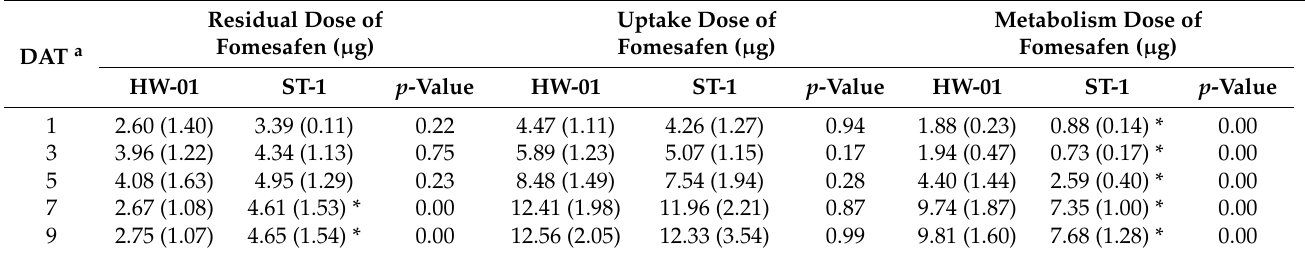
Table 5. Analysis of metabolic dynamics of fomesafen in A. retroflexus plants.